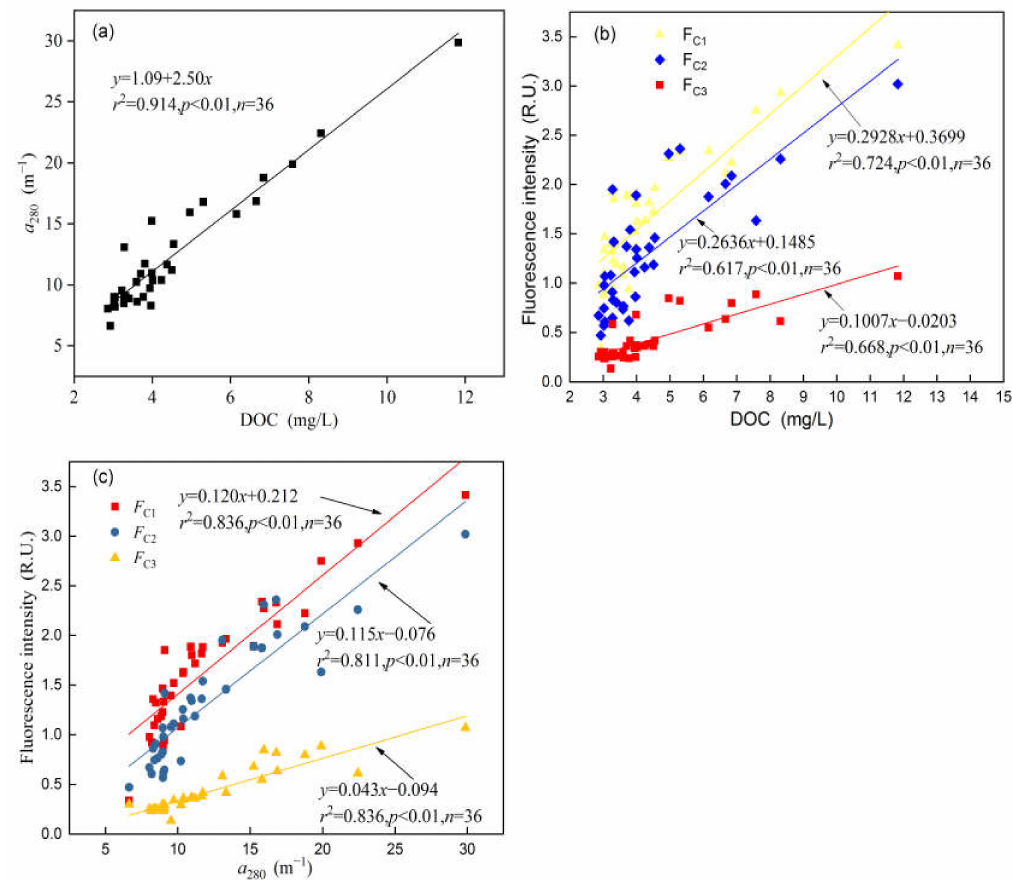
Figure 5. Correlation between a 280 , DOC, and the fluorescence intensities of FDOM components in the overlying water of Lake Taihu. ( a ) Correlation between DOC and a 280 ; ( b ) Correlation between DOC and fluorescence intensities of FDOM components; ( c ) Correlation between a 280 and fluorescence intensities of FDOM